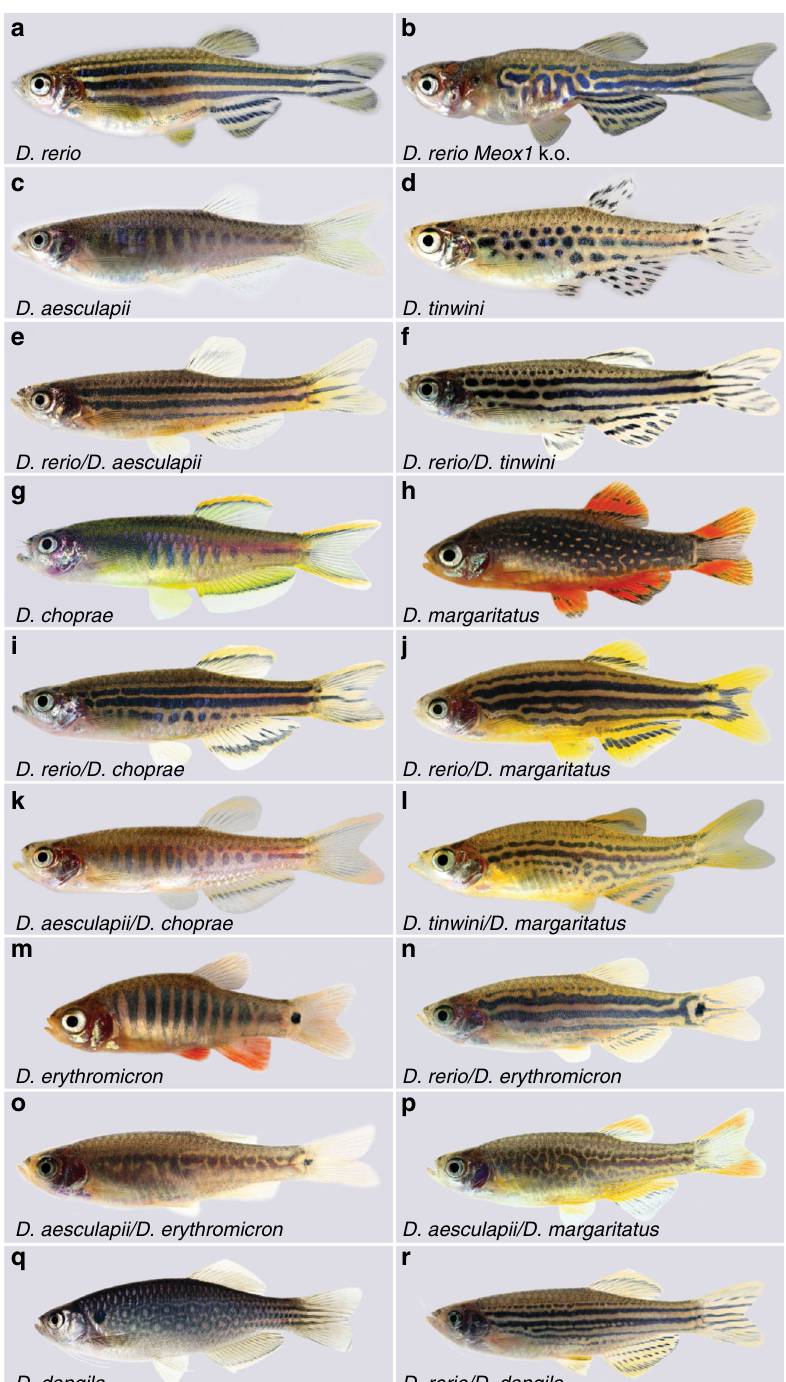
Fig. 1 Colour patterns in Danio fi sh and interspeci fi c hybrids. a Colour pattern of zebra fi sh, D. rerio . b D. rerio Meox1 ( choker ) mutants, which lack a horizontal myoseptum. c D. aesculapii . d D. tinwini . e Hybrid between D. rerio and D. aesculapii and f hybrid between D. rerio and D. tinwini . g D. choprae . h D. margaritatus . i Hybrid between D. rerio and D. choprae , j and hybrid between D. rerio and D. margaritatus . k Hybrid between D. aesculapii and D. choprae . l Hybrid between D. tinwini and D. margaritatus . m D. erythromicron . n Hybrid between D. rerio and D. erythromicron . o Hybrid between D. aesculapii and D. erythromicron . p Hybrid between D. aesculapii and D. margaritatus . q D. dangila . r Hybrid between D. rerio and D. dangila . All pictures are representative for the corresponding species or hybrids; for the variability of hybrid patterns see Supplementary Fig 1. Please note that not all panels are shown to the same scale; the sizes of the fi sh are ~18 mm ( D. margaritatus and D. erythromicron ), 24 mm ( D. tinwini ), 30 mm ( D. choprae ), 35 mm ( D. rerio , D. aesculapii ) and 75 mm ( D. dangila